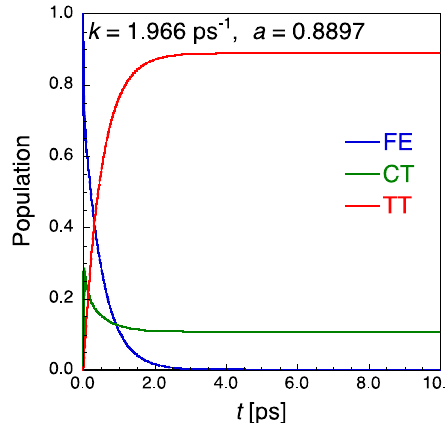
Figure 2. Time-evolution of diabatic exciton state {FE, CT, TT} populations for the pentacene dimer model (Figure 1b) with FE coupling V ex = − 34.22 meV by the QME approach. The SF rate k [ps − 1 ] and TT yield a [ − ] are also shown.